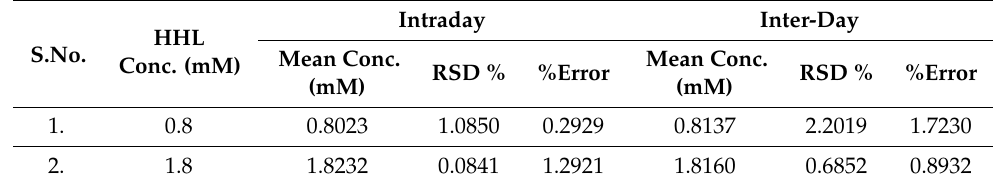
Mean Conc. RSD % (mM)